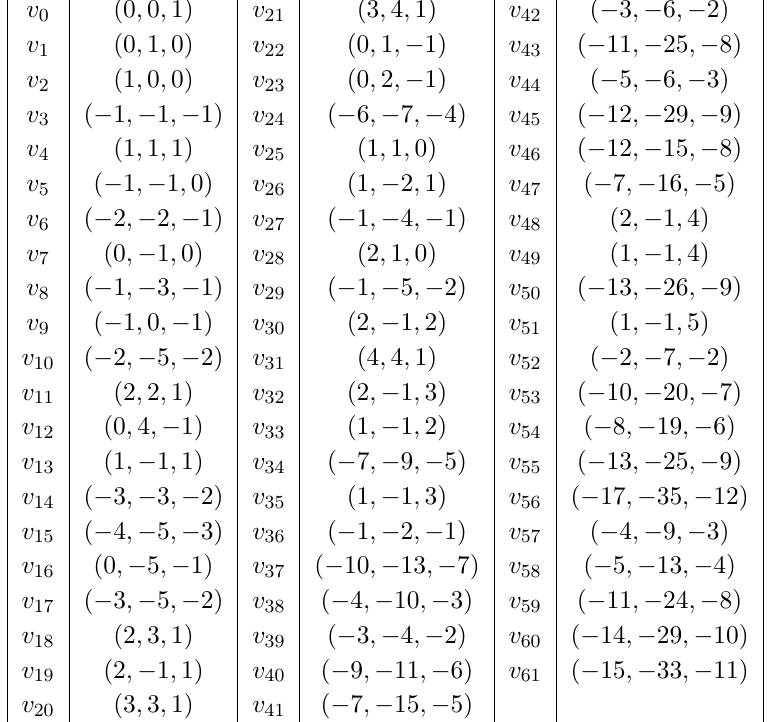
Table 4 . The list of toric rays of the exotic starting point B ex .